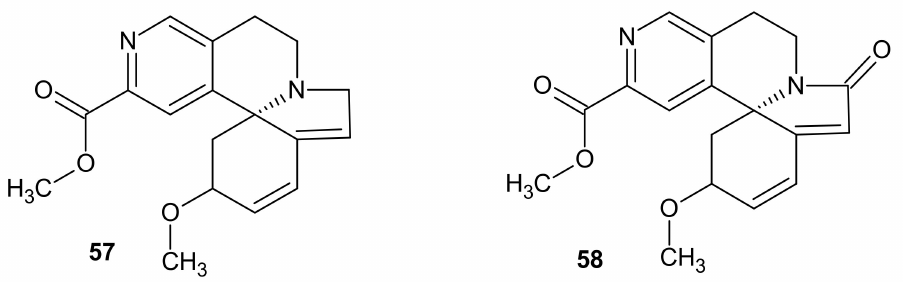
Figure 18. Erymelanthine 57 and melanacanthine 58 .